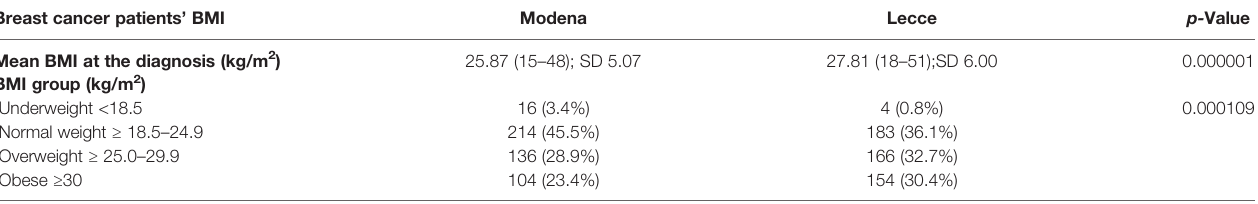
TABLE 3 | BMI at baseline of BC patients.